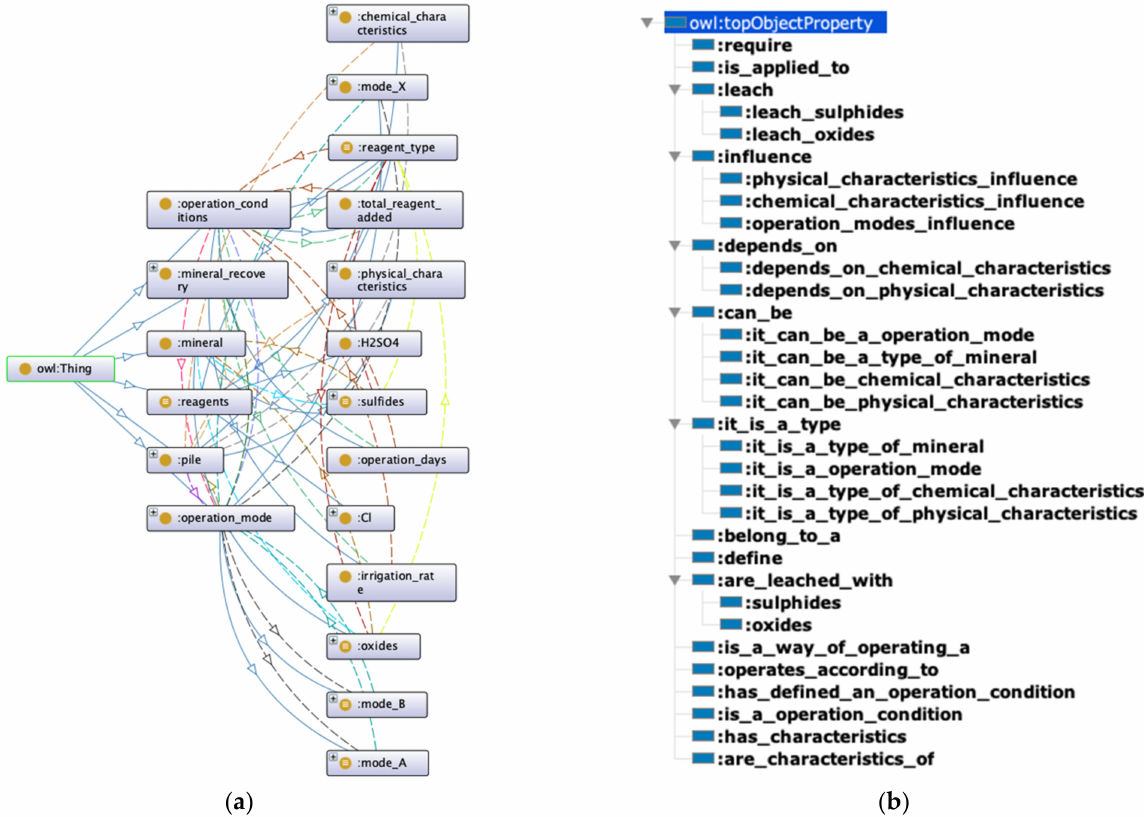
Figure 3. Class hierarchy of the ontology for the definition of operation modes ( a ) and hierarchy of properties associated with the classes of the ontological representation ( b